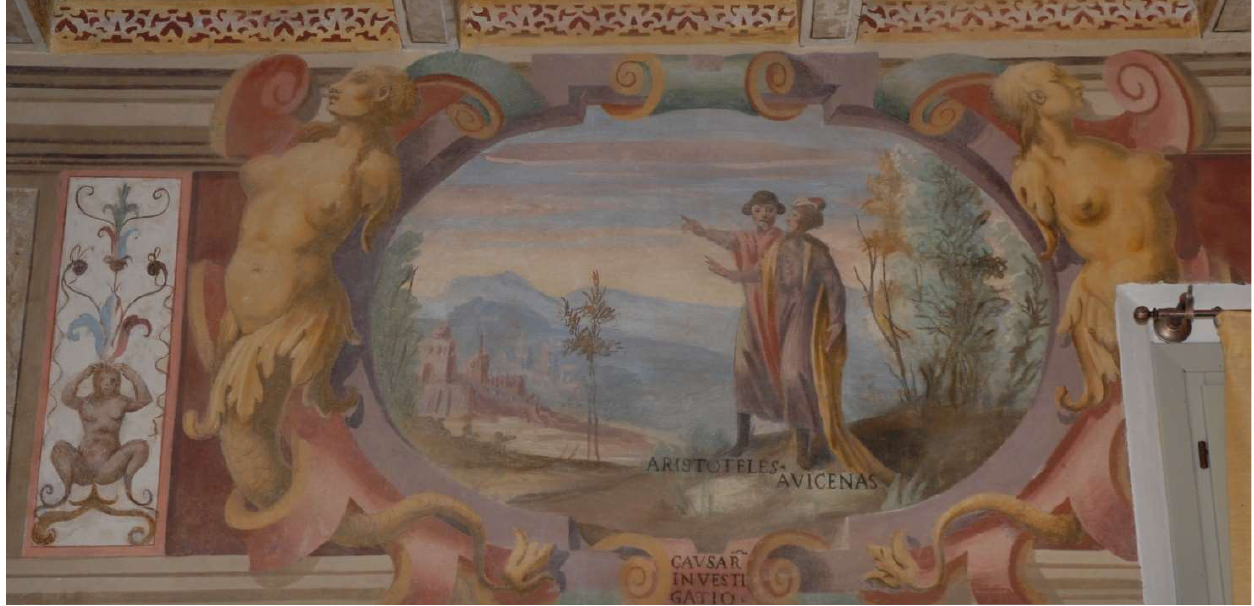
Figure 9. The oval painting depicting Aristotle and Avicenna in the act of scrutinizing the skies.